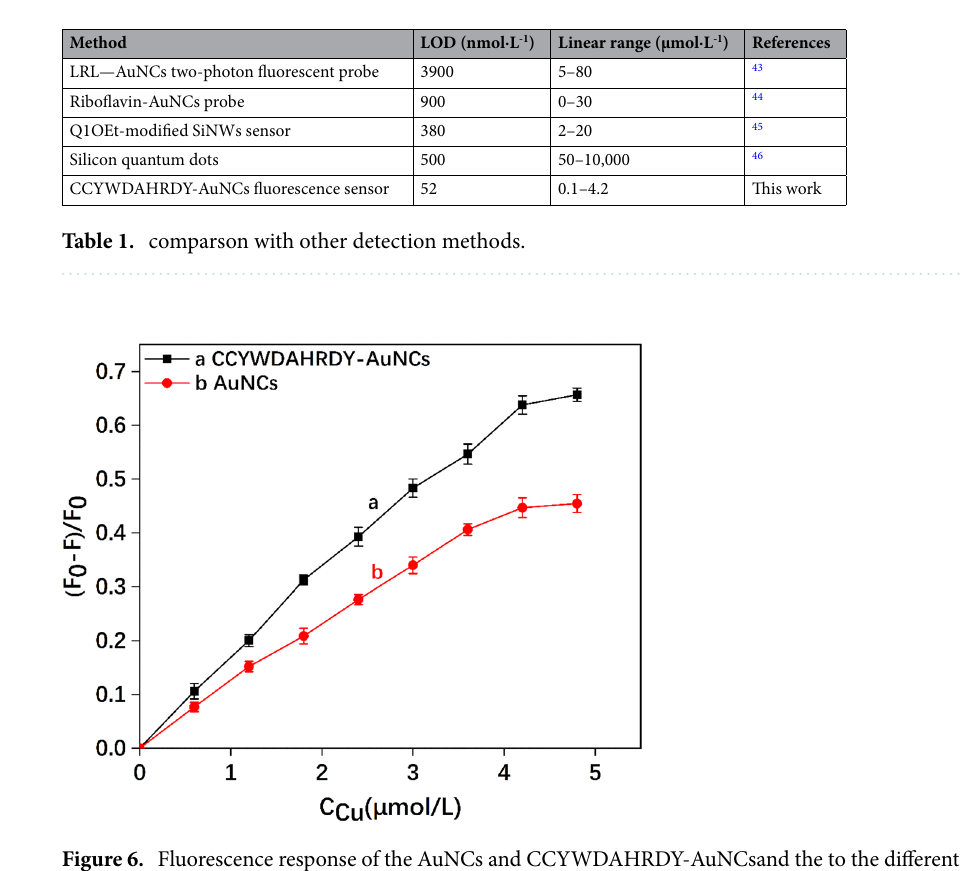
Figure 6. Fluorescence response of the AuNCs and CCYWDAHRDY-AuNCsand the to the different concentrations of Cu 2+ .